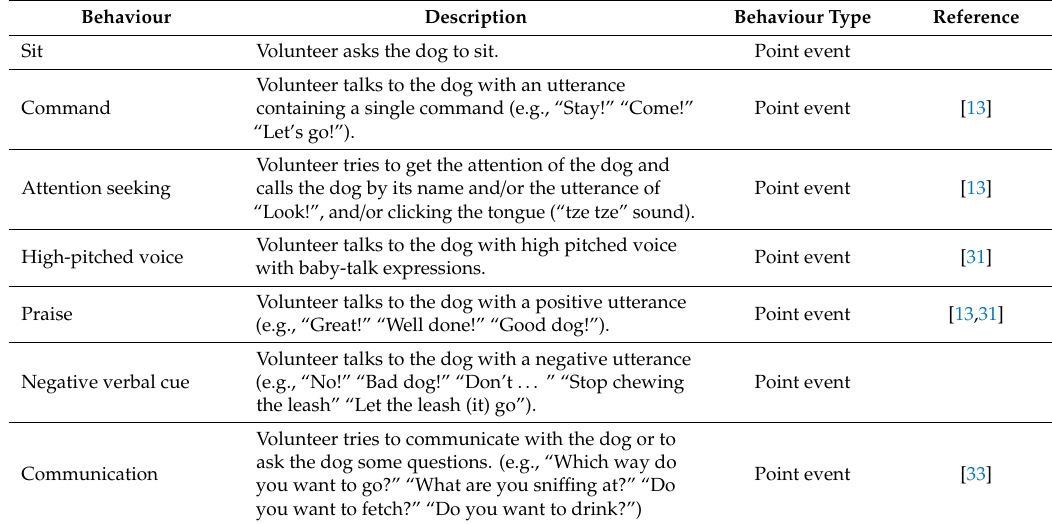
Table 4. Ethogram of human verbal